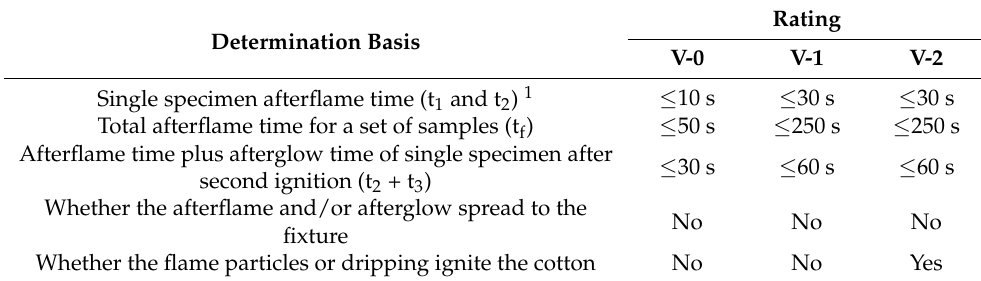
Table 2. Determination basis for vertical combustion test (UL-94) rating according to the GB/T 2408-2008 standard. Determination Basis